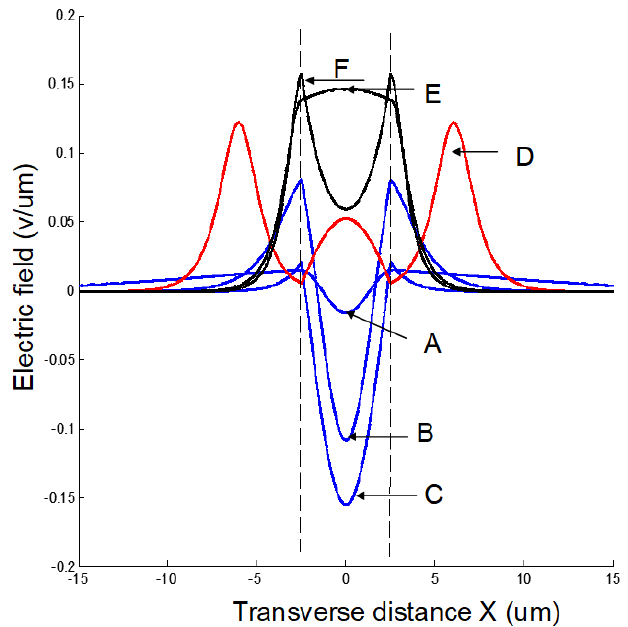
Figure 5. The electric field distributions with respect to the six points, A, B, C, D, E, and F, shown in Figure 4.